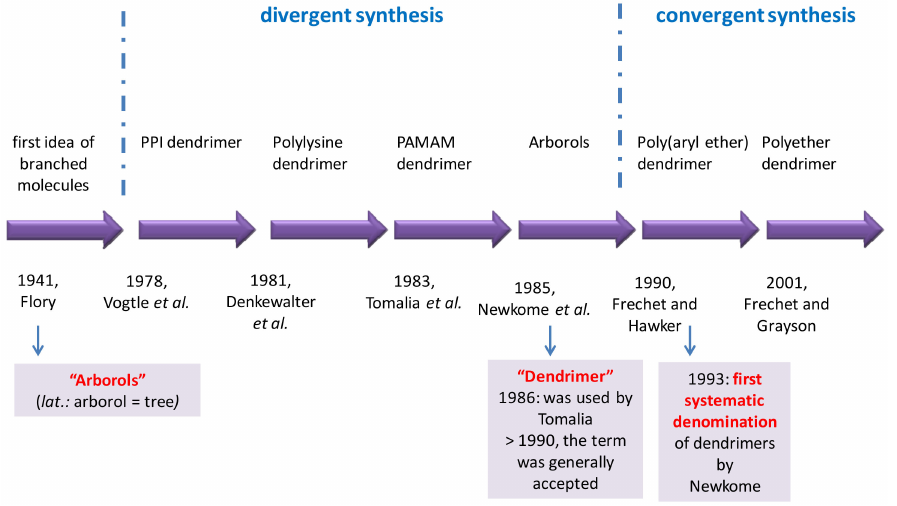
Figure 6. Schematic history of dendrimers